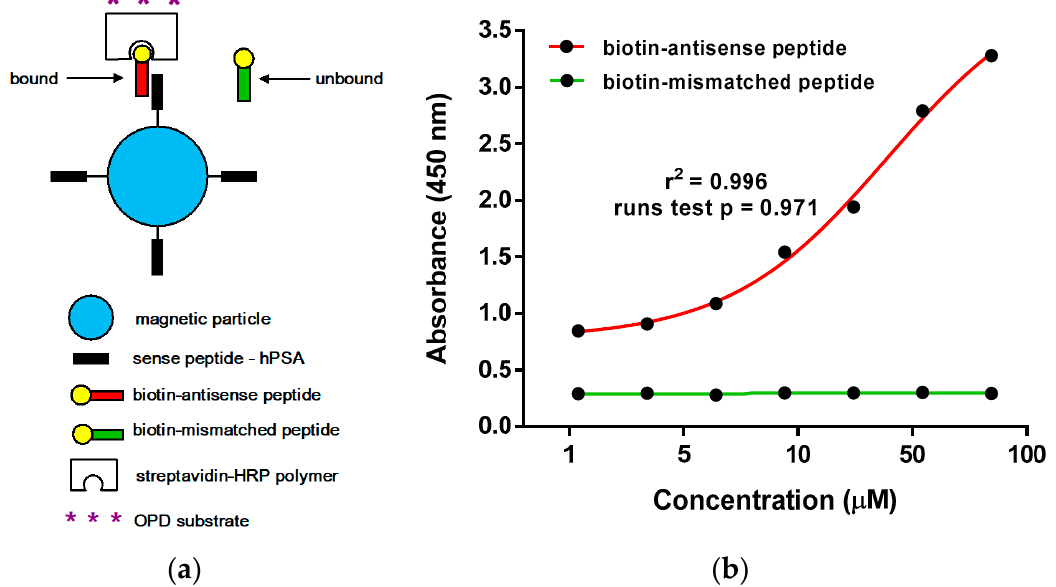
Figure 4. ( a ) Schematic representation of the magnetic particle enzyme immunoassay (MPEIA) based on the binding of sense hPSA peptide epitope coated onto SPHERO ™ carboxyl magnetic particles and biotinylated antisense peptide paratope. ( b ) Detection of hPSA epitope RHSLFHP by magnetic particle enzyme immunoassay, using biotinylated antisense peptide AVRDKVG (red titration curve). Biotinylated mismatched peptide EHFRW was a negative control (green titration curve).